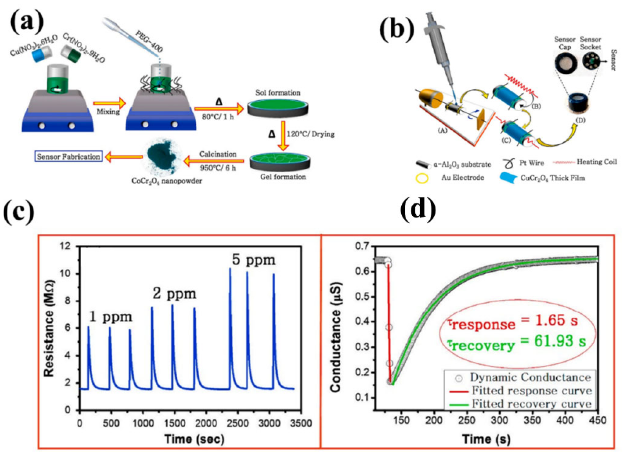
Figure 2. ( a ) Schematic illustration of the CoCr 2 O 4 , ( b ) drop coating of the CoCr 2 O 4 slurry on the sensor transient conductance curve of the sensor by Langmuir absorption model at 300 °C, Reprinted with substrate, ( c ) dynamic response of the CoCr 2 O 4 sensor to different traces of acetone vapor ( d ) transient permission from [55] Copyright 2021 Elsevier. conductance curve of the sensor by Langmuir absorption model at 300 ◦ C, Reprinted with permission from [55] Copyright 2021 Elsevier. Coatings 2022 , 12 , x FOR PEER REVIEW 11 of 29